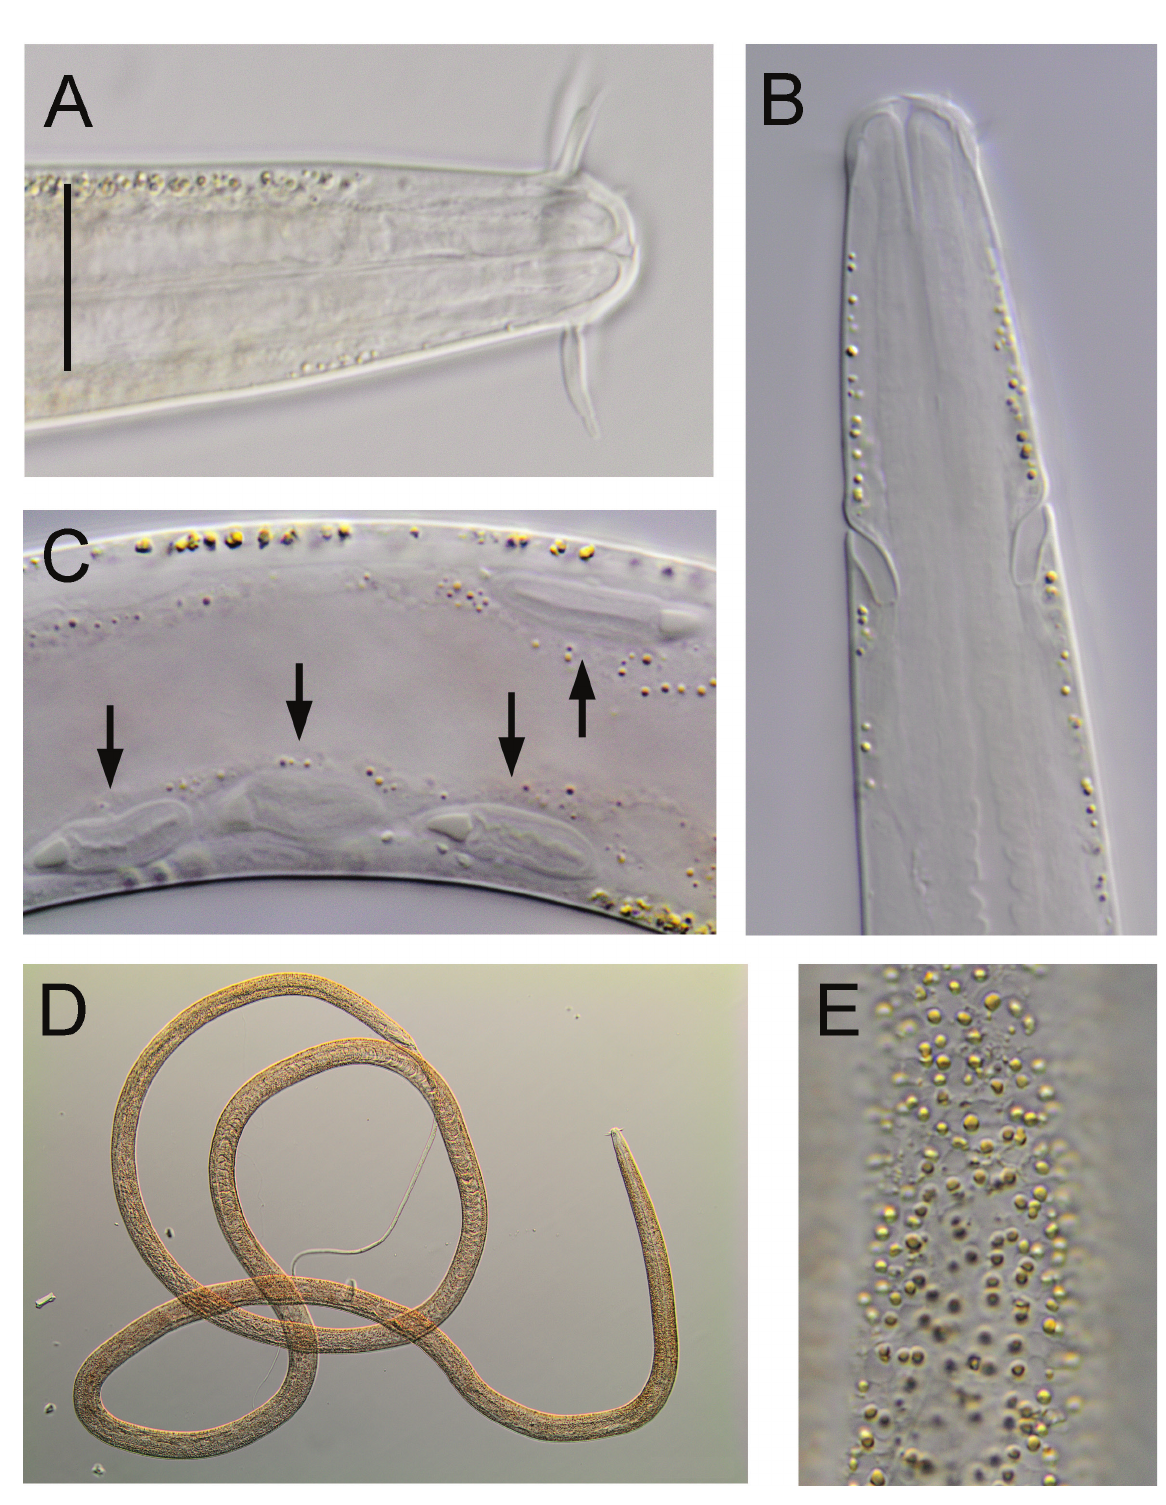
Fig. 4. Trefusialaimus idrisi sp. nov. Light micrographs. A . Anterior body region of male, lateral view. B . Anterior body region of juvenile, dorsal view. C . Mid-body region of juvenile, showing sperm cells in pseudocoelom. D . entire male. E . Lateral chord of male, showing round golden inclusions. Arrows point to sperm cells. Scale bar: A-C, E = 15 µm; D = 260